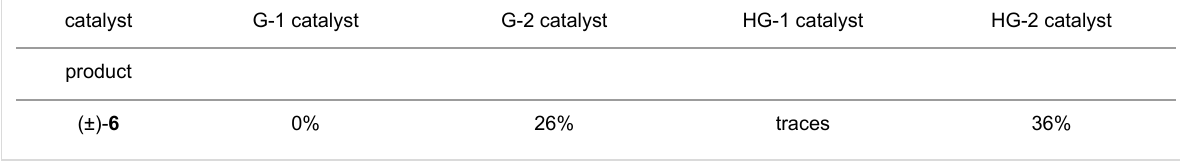
Table 2: Isolated yields for compound (±)- 6 formed in the ring-opening reaction of lactone (±)- 4 with ethylene in ROM reactions with various